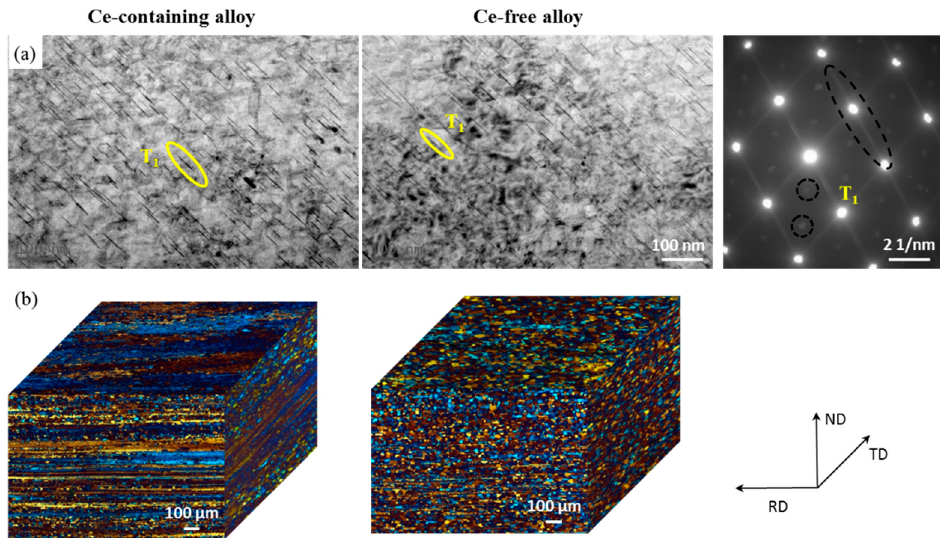
Figure 1. Microstructures comparison of Ce-containing and Ce-free alloys at T8 temper: ( a ) TEM image of T1 phase; ( b ) three direction optical micrographs of grain structure.